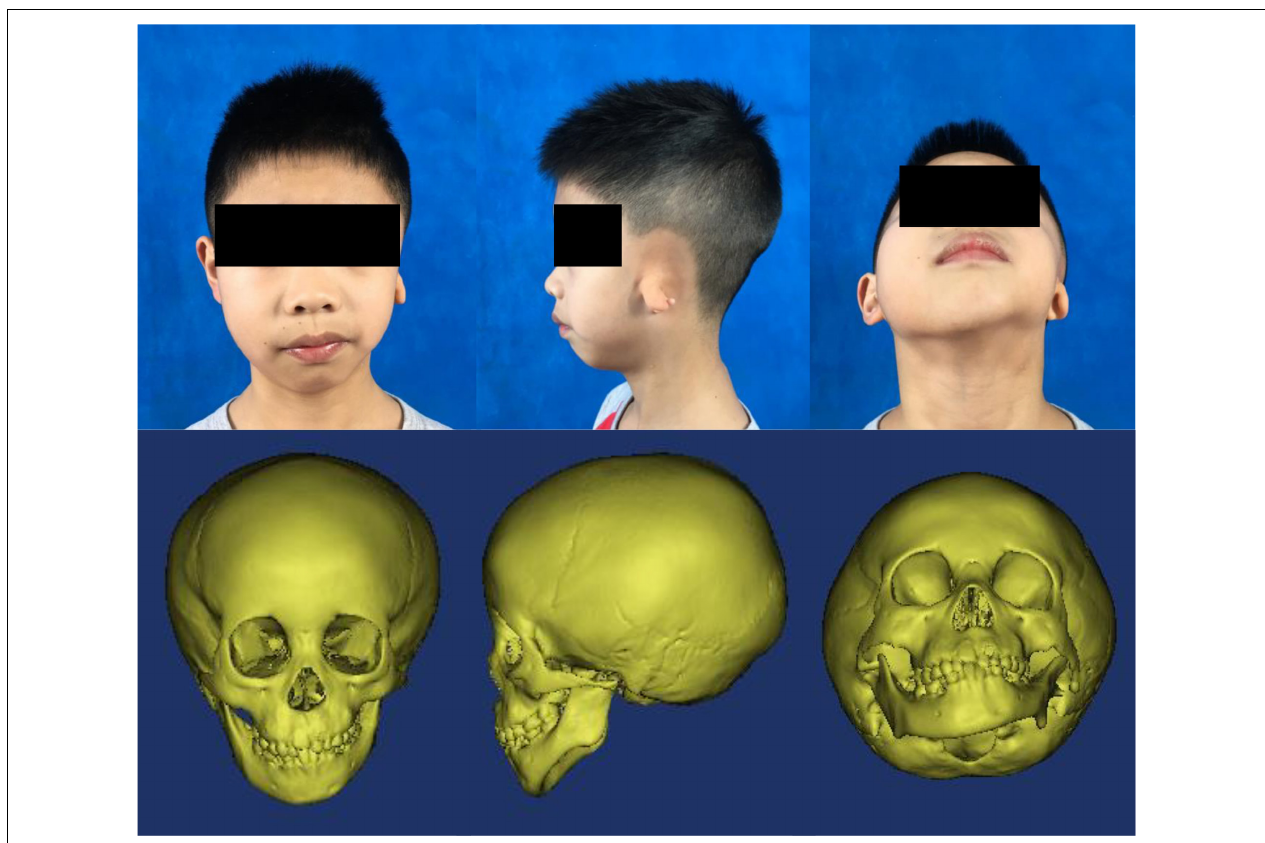
FIGURE 1 | Typical photos and computed tomography scan images of a patient with hemifacial microsomia. From left to right: front, left-lateral, and upward